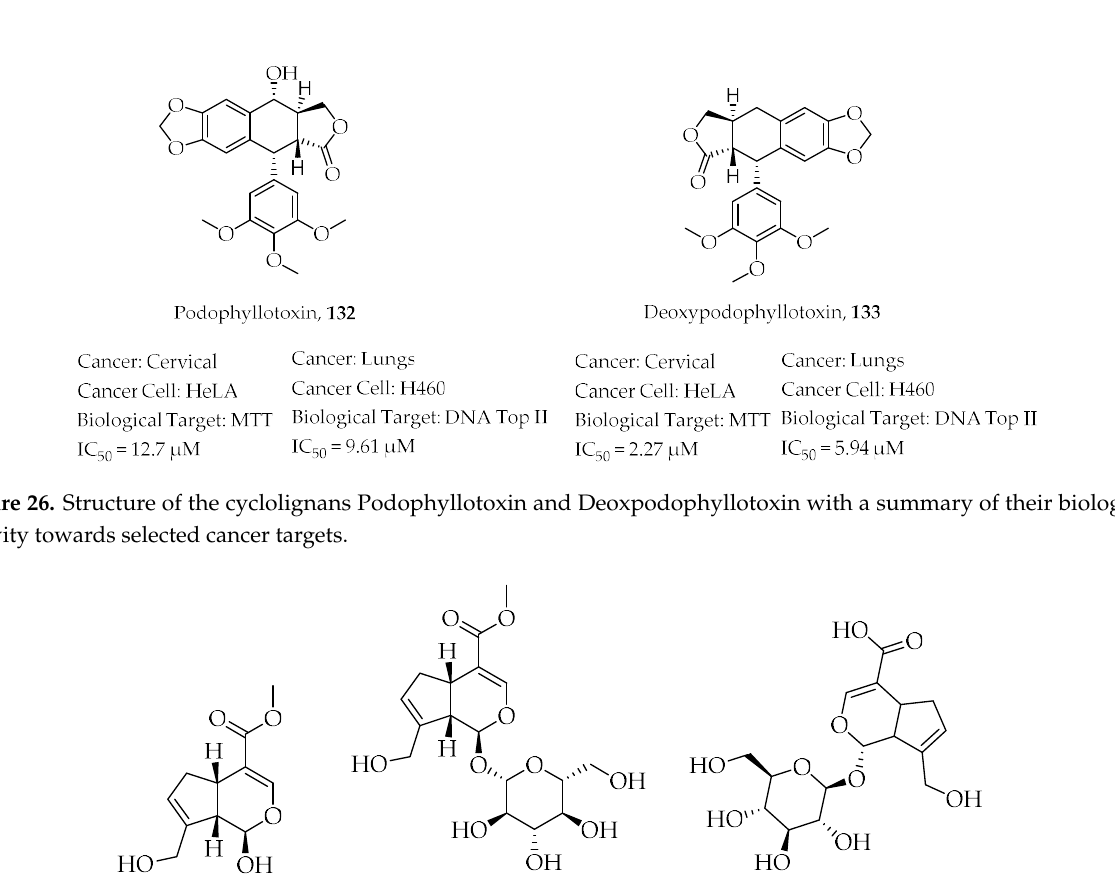
Figure 26. Structure of the cyclolignans Podophyllotoxin and Deoxpodophyllotoxin with a sum- mary of their biological activity towards selected cancer targets.